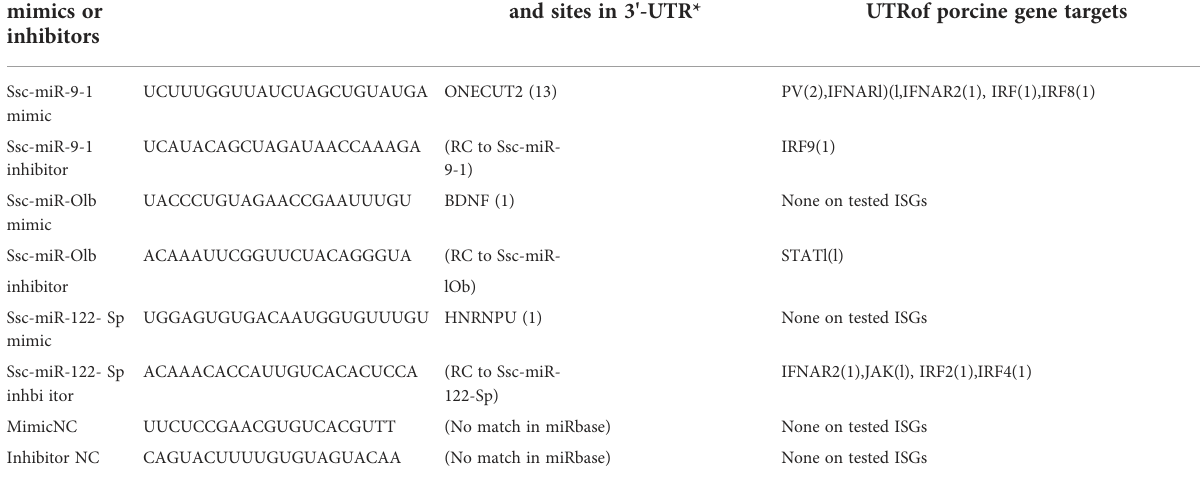
TABLE 7 Selected miRNAs for functional validation.